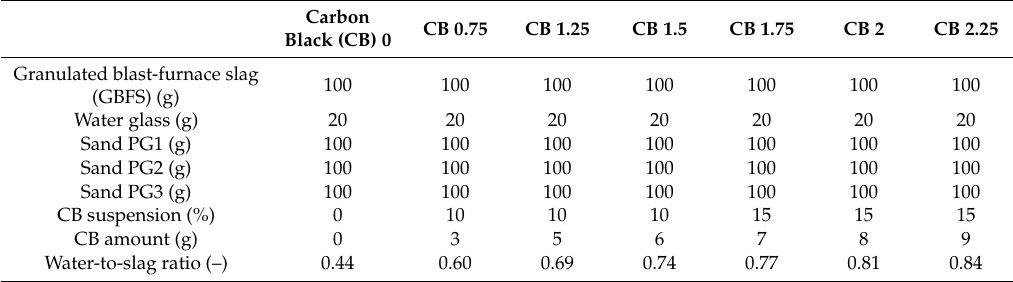
Table 1. Compositions of the studied